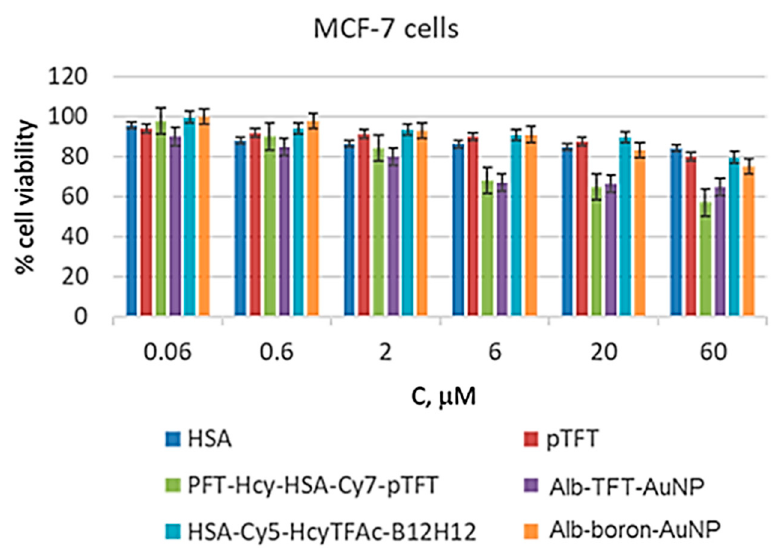
Figure 3. In vitro cytotoxicity of all formulations evaluated using MCF-7 cells by MTT assay [44] ( n = 3). The MCF-7 cell line was incubated for 72 h with HSA (dark blue), pTFT (red), PFT-Hcy-HSA-Cy7-pTFT (green), alb-TFT-AuNP (violet), HSA-Cy5-Hcy-TFAc-B 12 H 12 (cyan), and alb-boron-AuNP (orange) loaded at various concentrations. Cell viability was normalized using the cells treated with a PBS buffer as a 100% viability control.